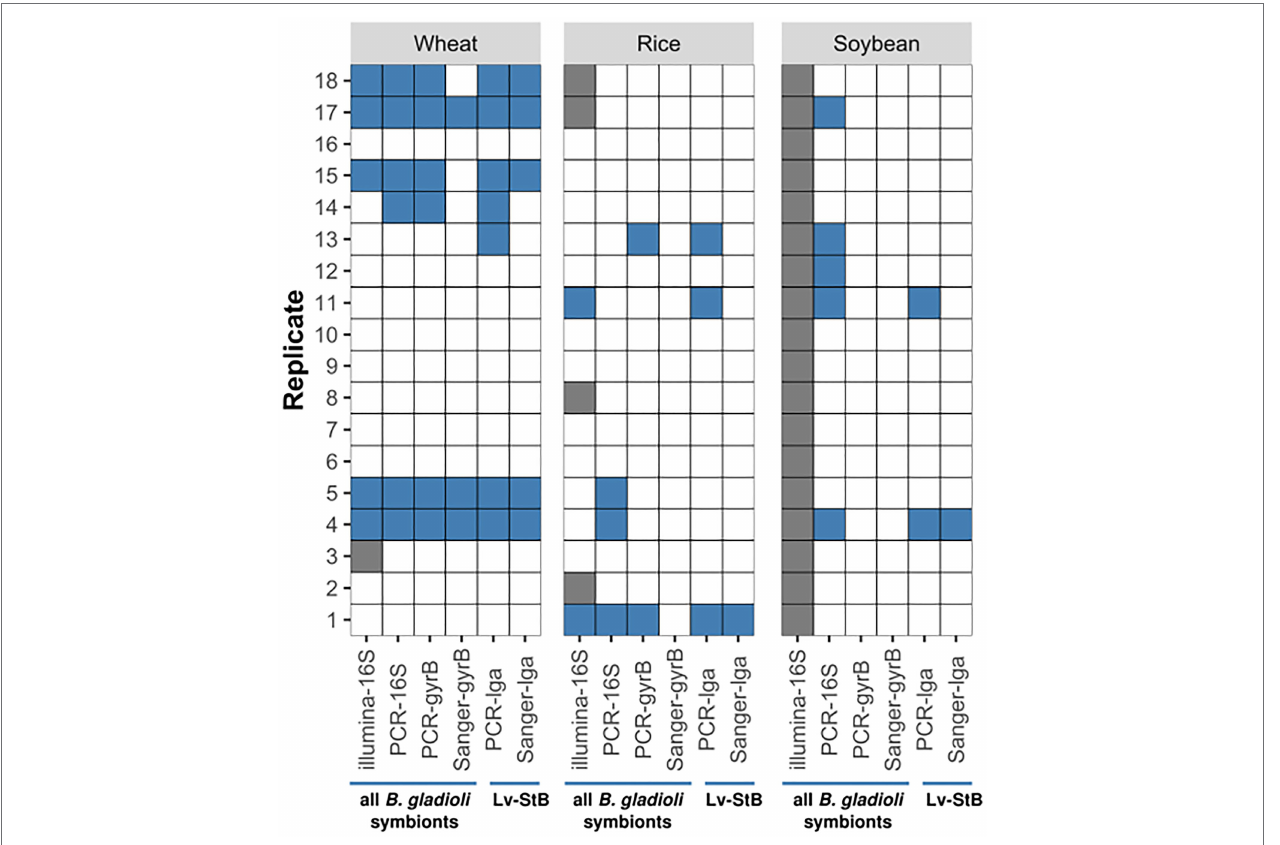
FIGURE 1 | Transmission of Burkholderia strains from Lagria villosa adults to wheat, rice, and soybean plants. Results were obtained with diagnostic PCRs using Burkholderia -specific primers targeting the 16S rRNA and gyrB genes, or Burkholderia Lv-StB – specific primers targeting the lgaG gene. Sanger or Illumina sequencing was carried out for the obtained amplicons. The B. gladioli strains targeted by each method are indicated below the blue horizontal lines. Blue filled tiles represent a positive indication of Burkholderia presence, empty tiles indicate no sign of Burkholderia presence, and grey tiles indicate the method was not applied on that sample. Occasionally, a signal was found via PCR but sequencing was unsuccessful. All controls ( N = 18 for wheat and rice, respectively, N = 9 for soybean) were negative across all